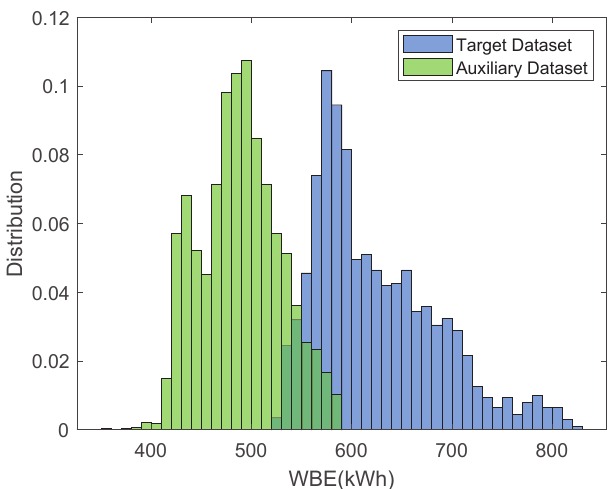
Figure 4. Classification of building types in the public dataset from the Great Energy Predictor III competition organized by ASHRAE.